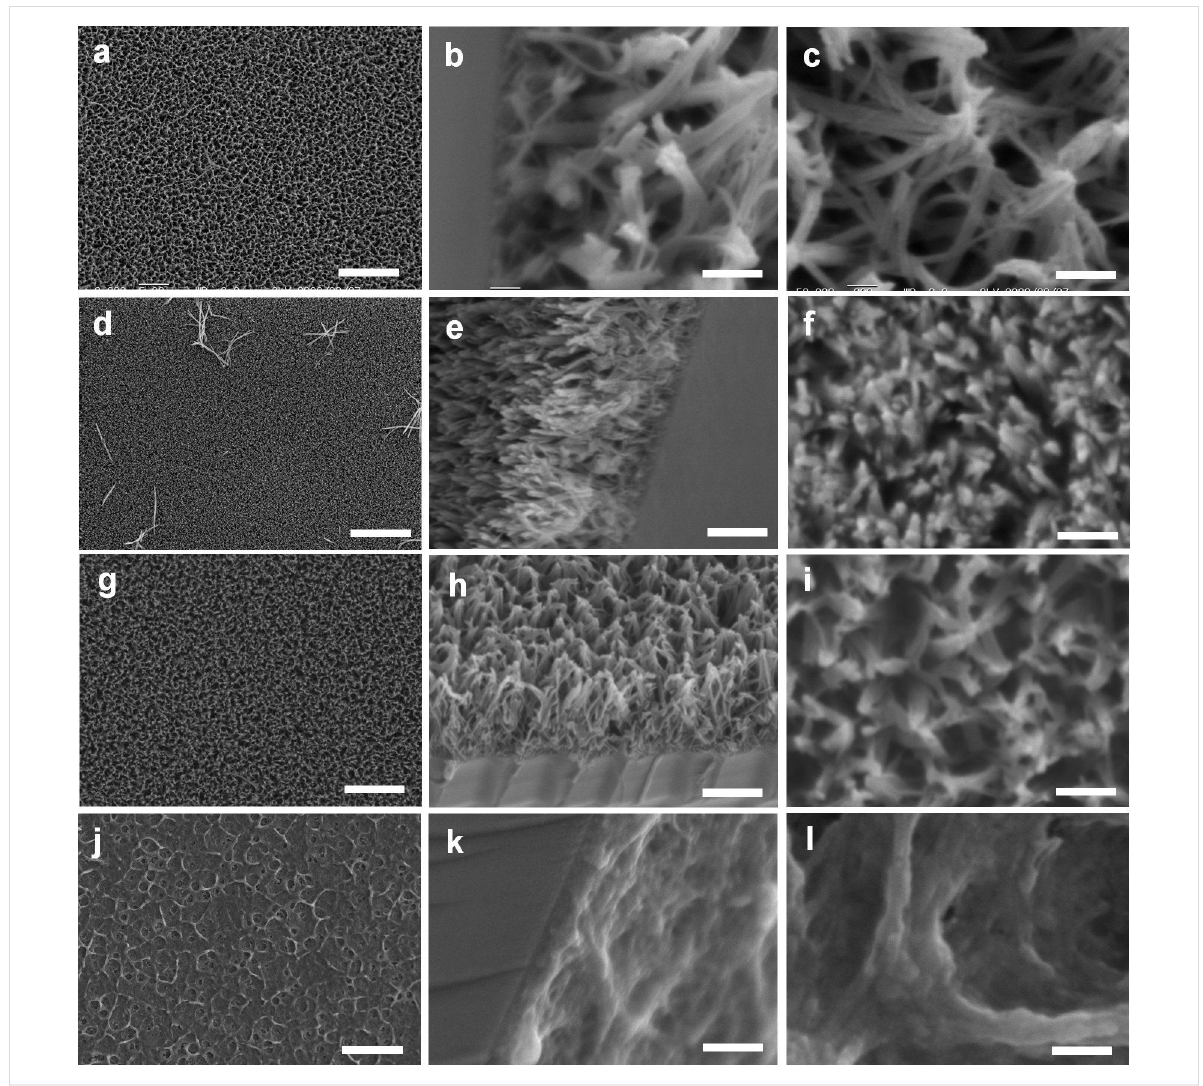
Figure 4: SEM images of the LPEI@silica nanograss surface obtained from silica sources with different concentrations: 50 vol % (3 mL TMOS and 3 mL water; a–c); 3.3 vol % (0.5 mL TMOS and 15 mL water; d–f); 0.25 vol % (0.25 mL TMOS in 100 mL water, g–i) and 0.1 vol % (0.1 mL TMOS in 100 mL water, j–l). The LPEI concentration is 5.0 wt % and the silica deposition was conducted at room temperature for 40 min. The scale bars are 10 μ m (a, d, g and j); 1 μ m (b, e, h, k and c); and 400 nm (f, i and